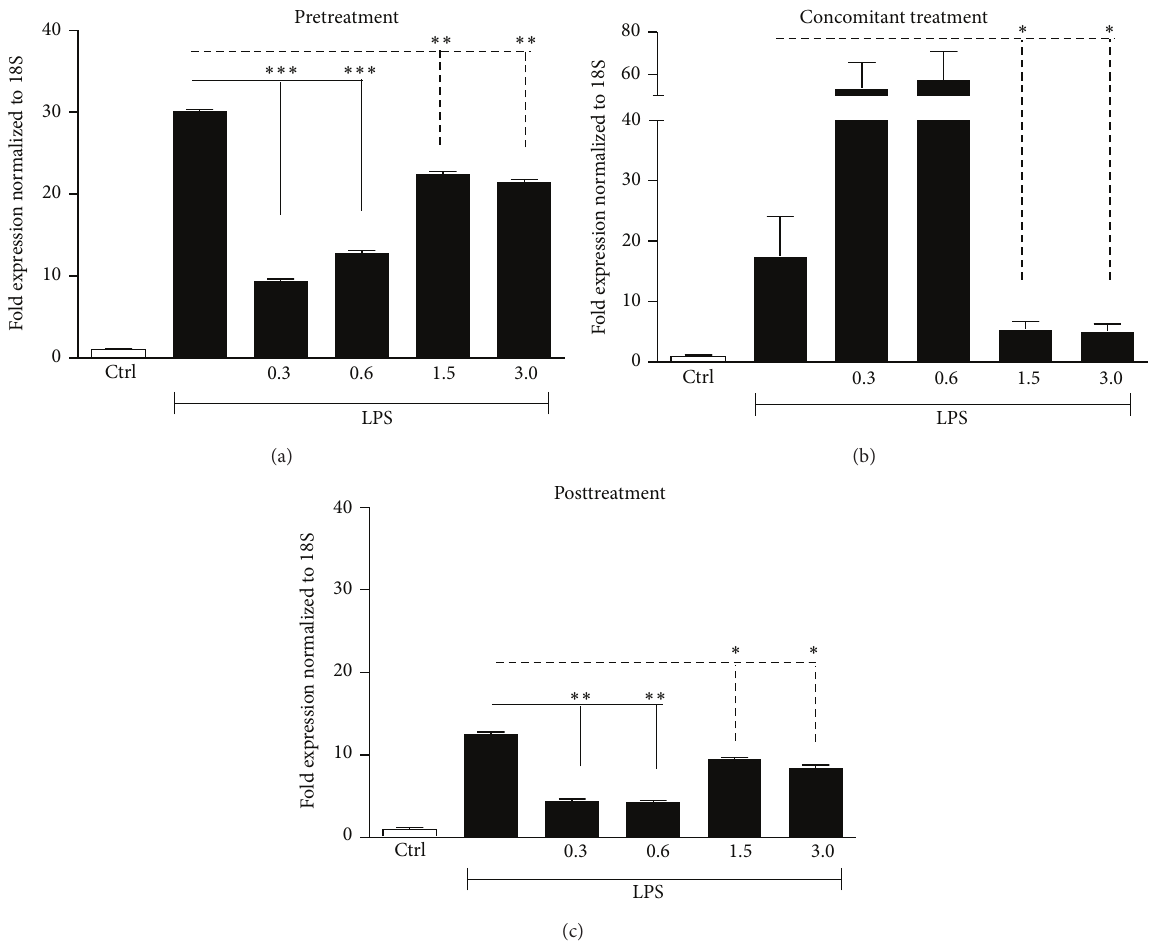
Figure 3: IL-8 gene expression, analyzed through qRT-PCR, in HaCaT cells stimulated with LPS (25 𝜇 g/mL) and incubated in pretreatment, concomitant, and posttreatment settings with low (0.3 mg/ 𝜇 L; 0.6mg/ 𝜇 L) and high (1.5mg/ 𝜇 L; 3 mg/ 𝜇 L) doxycycline doses. IL-8 gene expression in (a) cells stimulated with LPS for 24 h and successively incubated with doxycycline for further 24 h, mRNA extraction performed at 48h; (b) cells incubated with doxycycline immediately after LPS, mRNA extraction performed at 24 h; (c) cells pretreated with doxycycline for 24 h and successively stimulated with LPS; mRNA extraction at 48 h ( ∗ 𝑃 < 0.05 , ∗∗ 𝑃 < 0.01 , and ∗∗∗ 𝑃 < 0.001 ; ns: not statistically